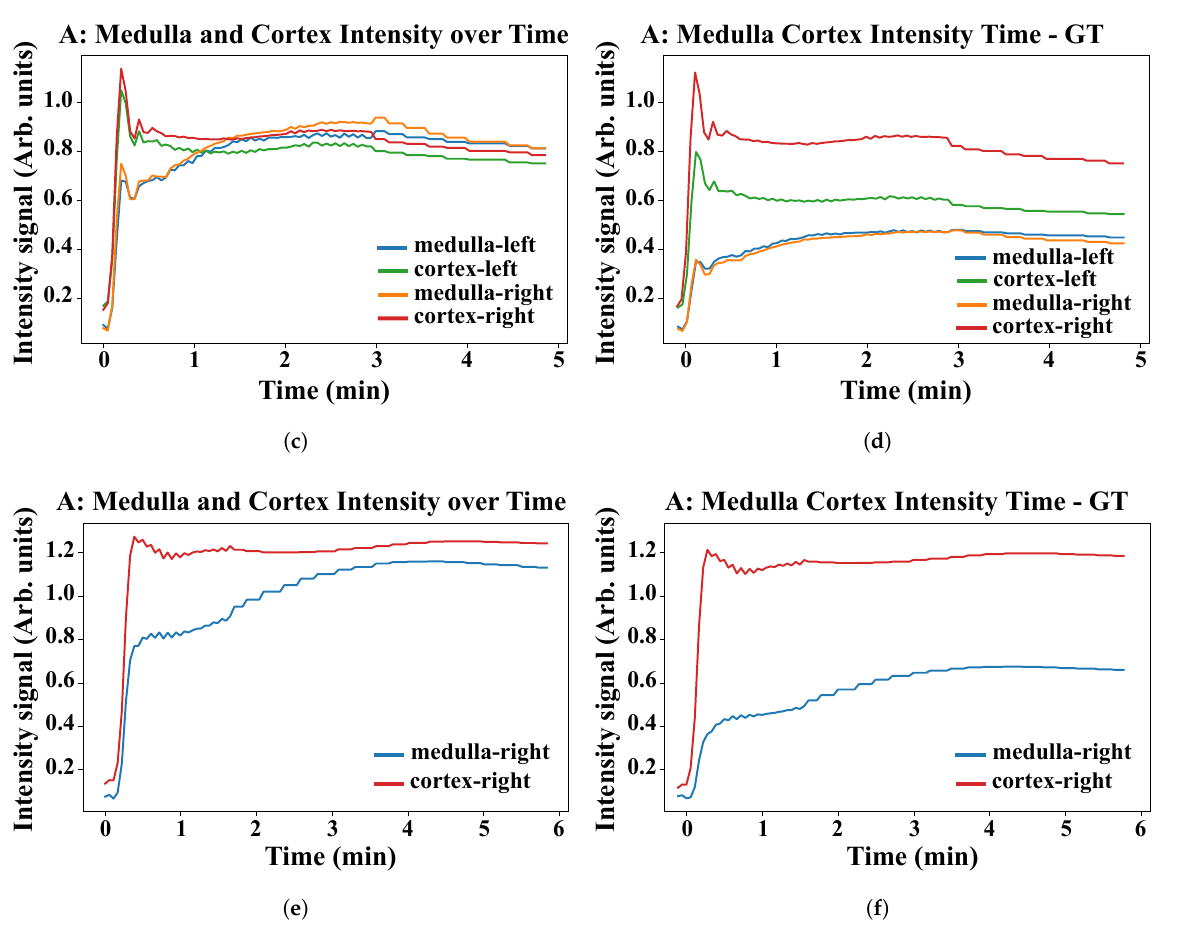
Figure A2. Graphs ( a – f ) represent the time–intensity curves of three clinically “abnormal” cases (scans or 4D volumes). The first column shows the relative contrast intensity enhancement of the automatic renal compartment segmentation in both the left and right kidneys over time (minutes). The second column shows the corresponding ground-truth (GT) time–intensity